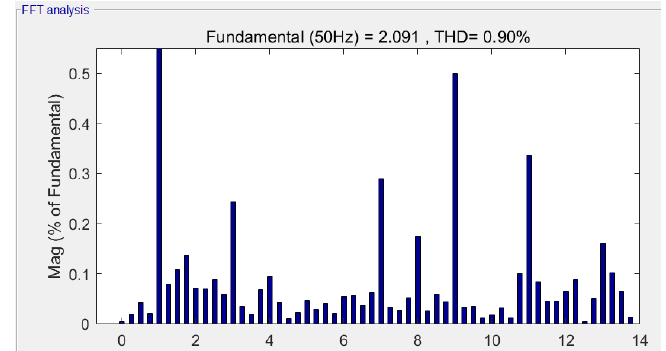
Figure 14. Five-phase voltage based on the new algorithm at m = 1.0514.